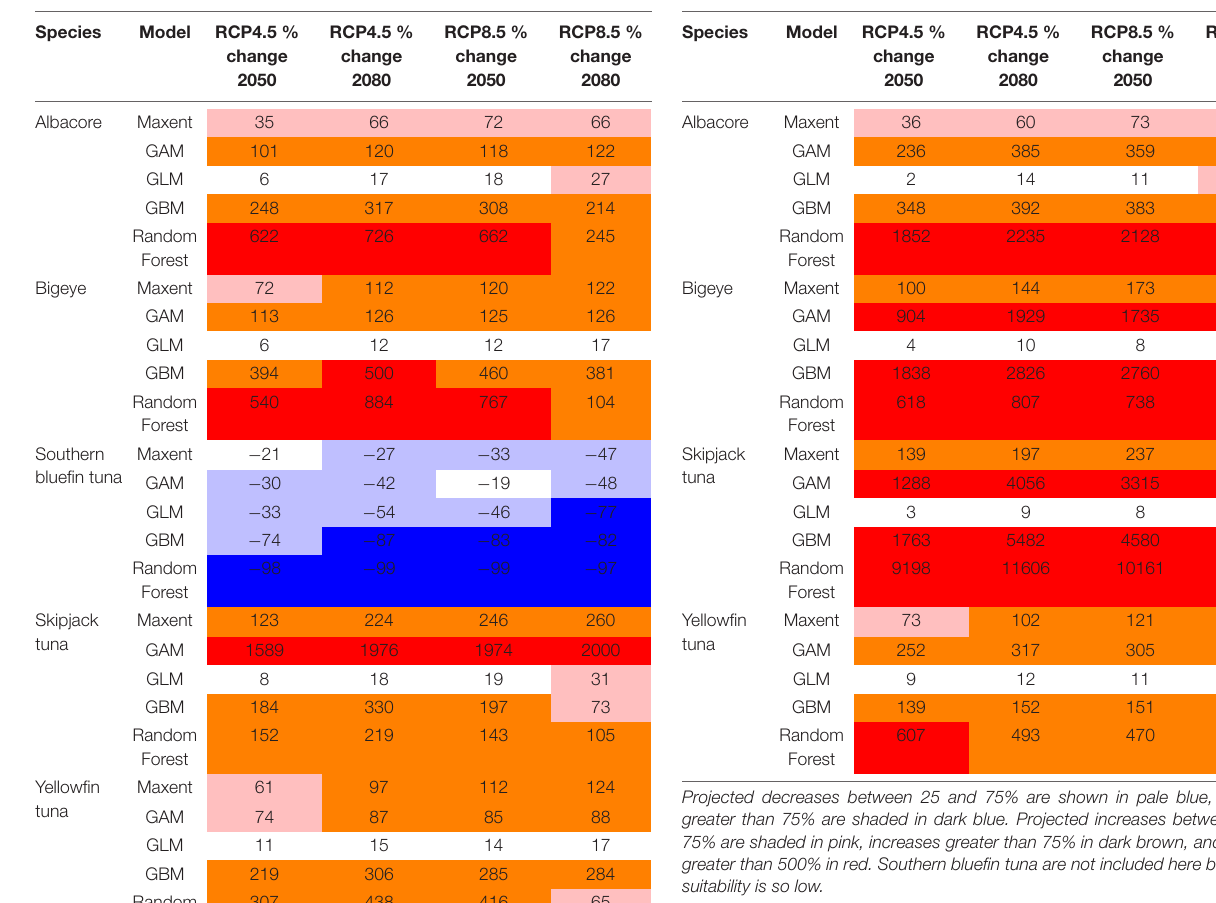
TABLE 3 | The minimum, median and maximum projected changes in habitat suitability in the Ascension Island EEZ for each species, for each model.